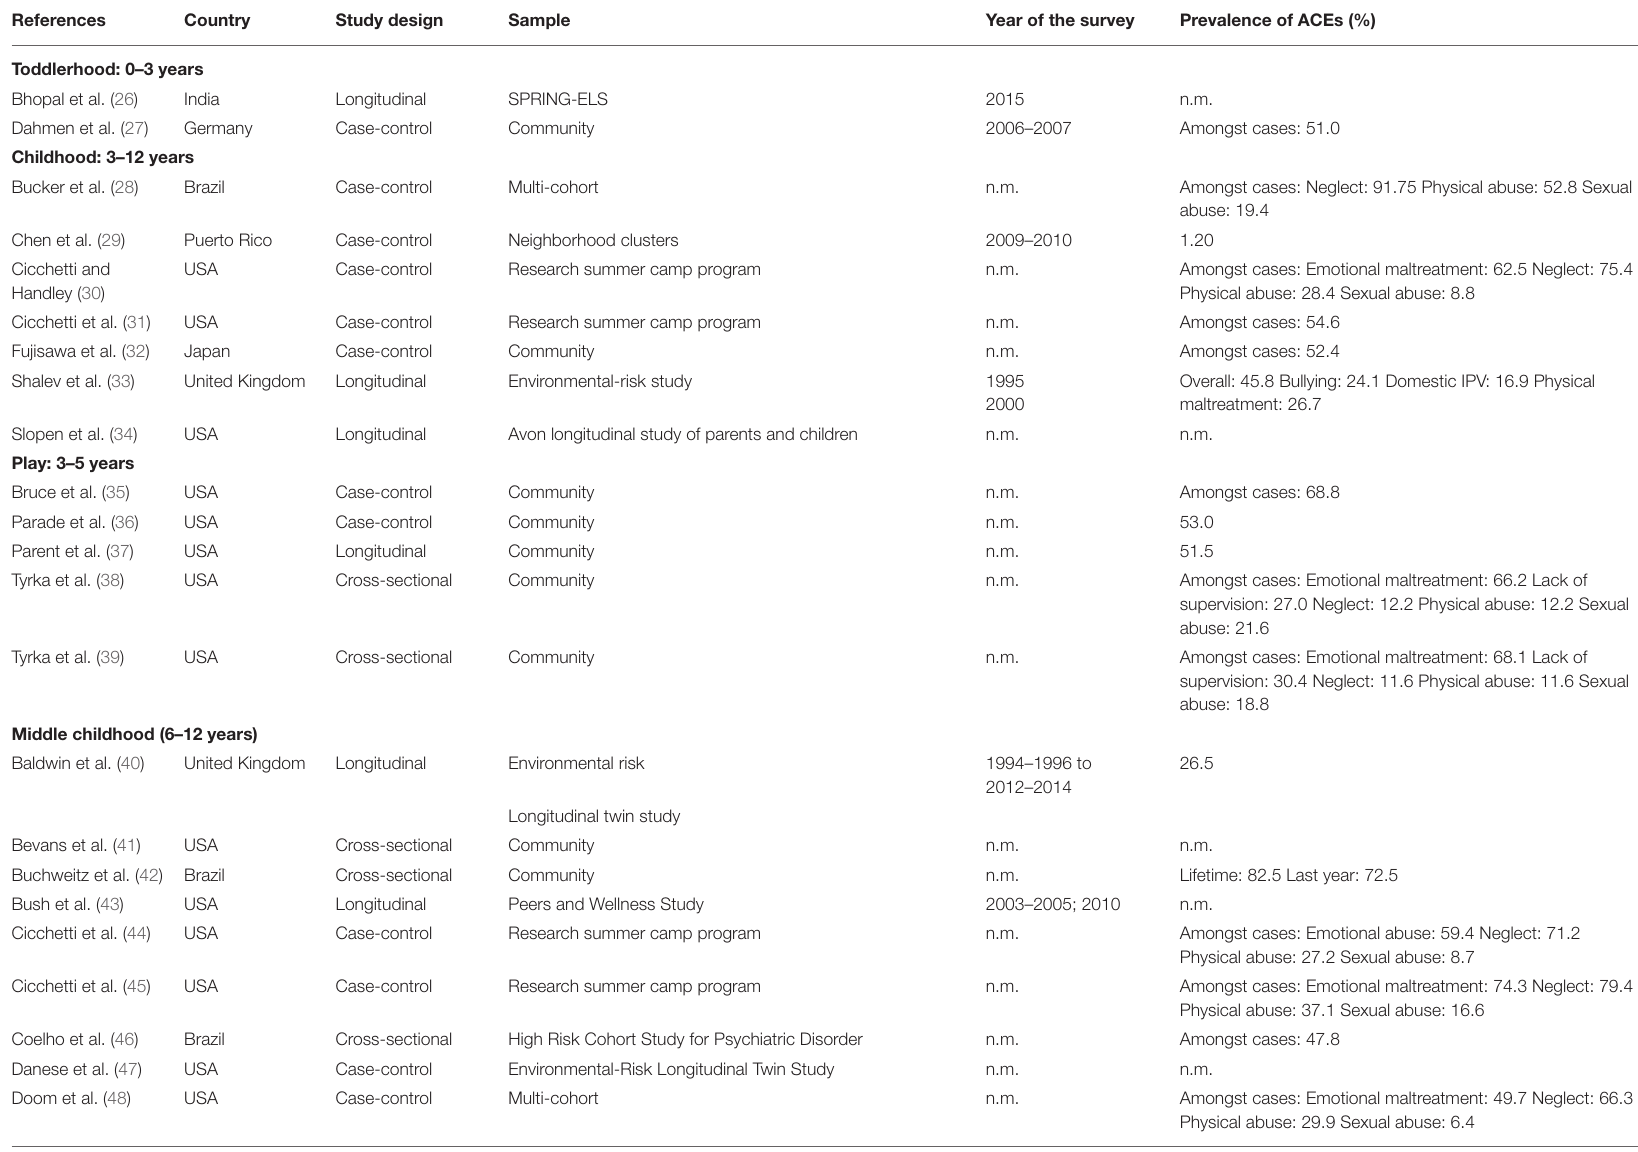
TABLE 3 | Descriptive characteristics of all included studies ( n =